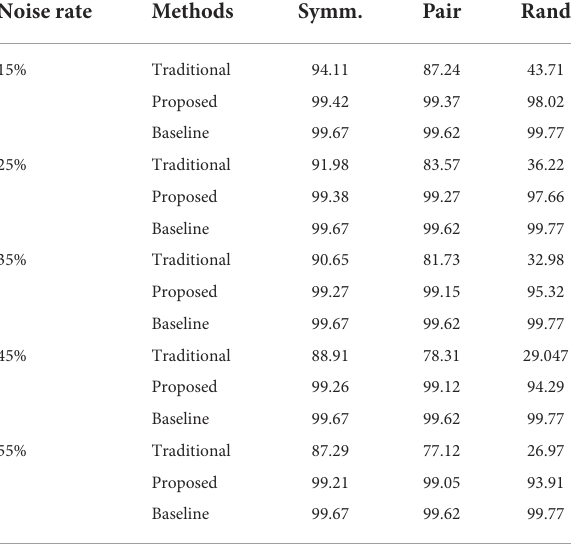
TABLE 1 Accuracy ( % ) on test